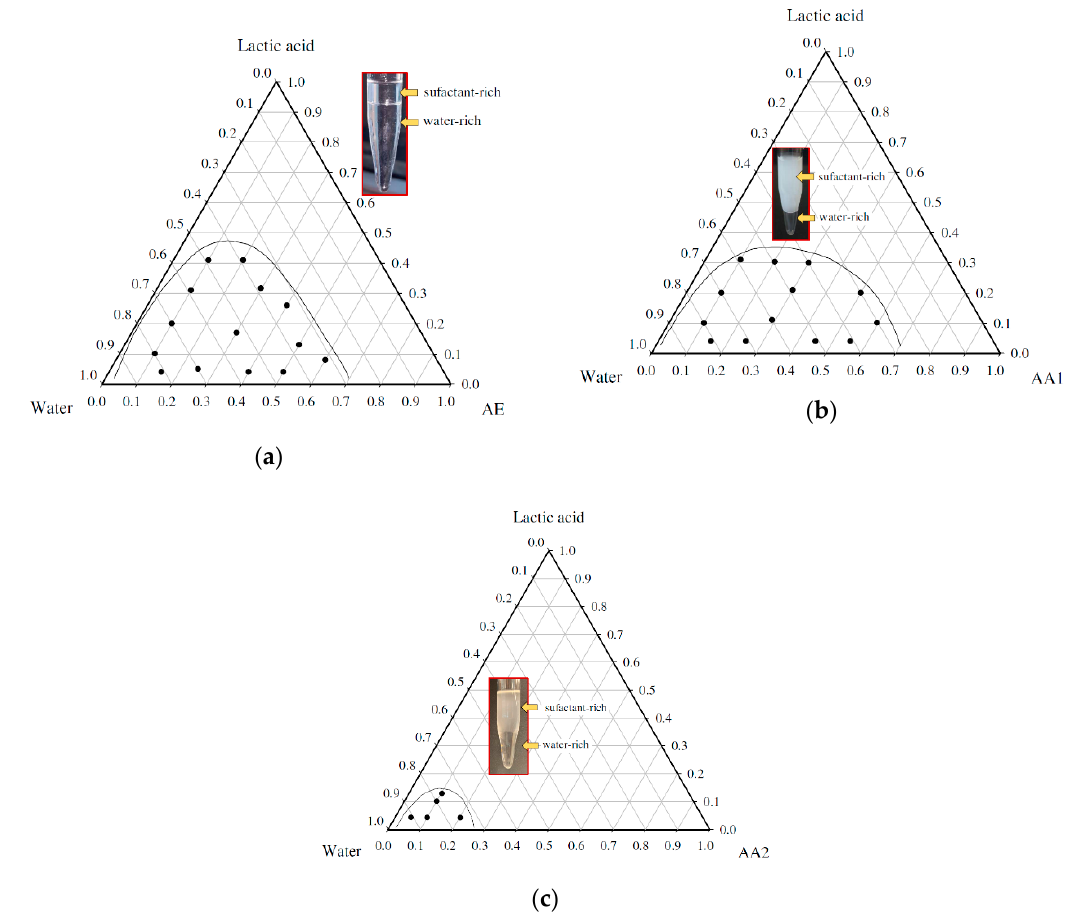
Figure 1. Estimated binodal curve for the system lactic acid + water + surfactant at T = 308.15 K and P = 0.1 MPa (atmospheric pressure): ( a ) AE; ( b ) AA1; ( c ) AA2.